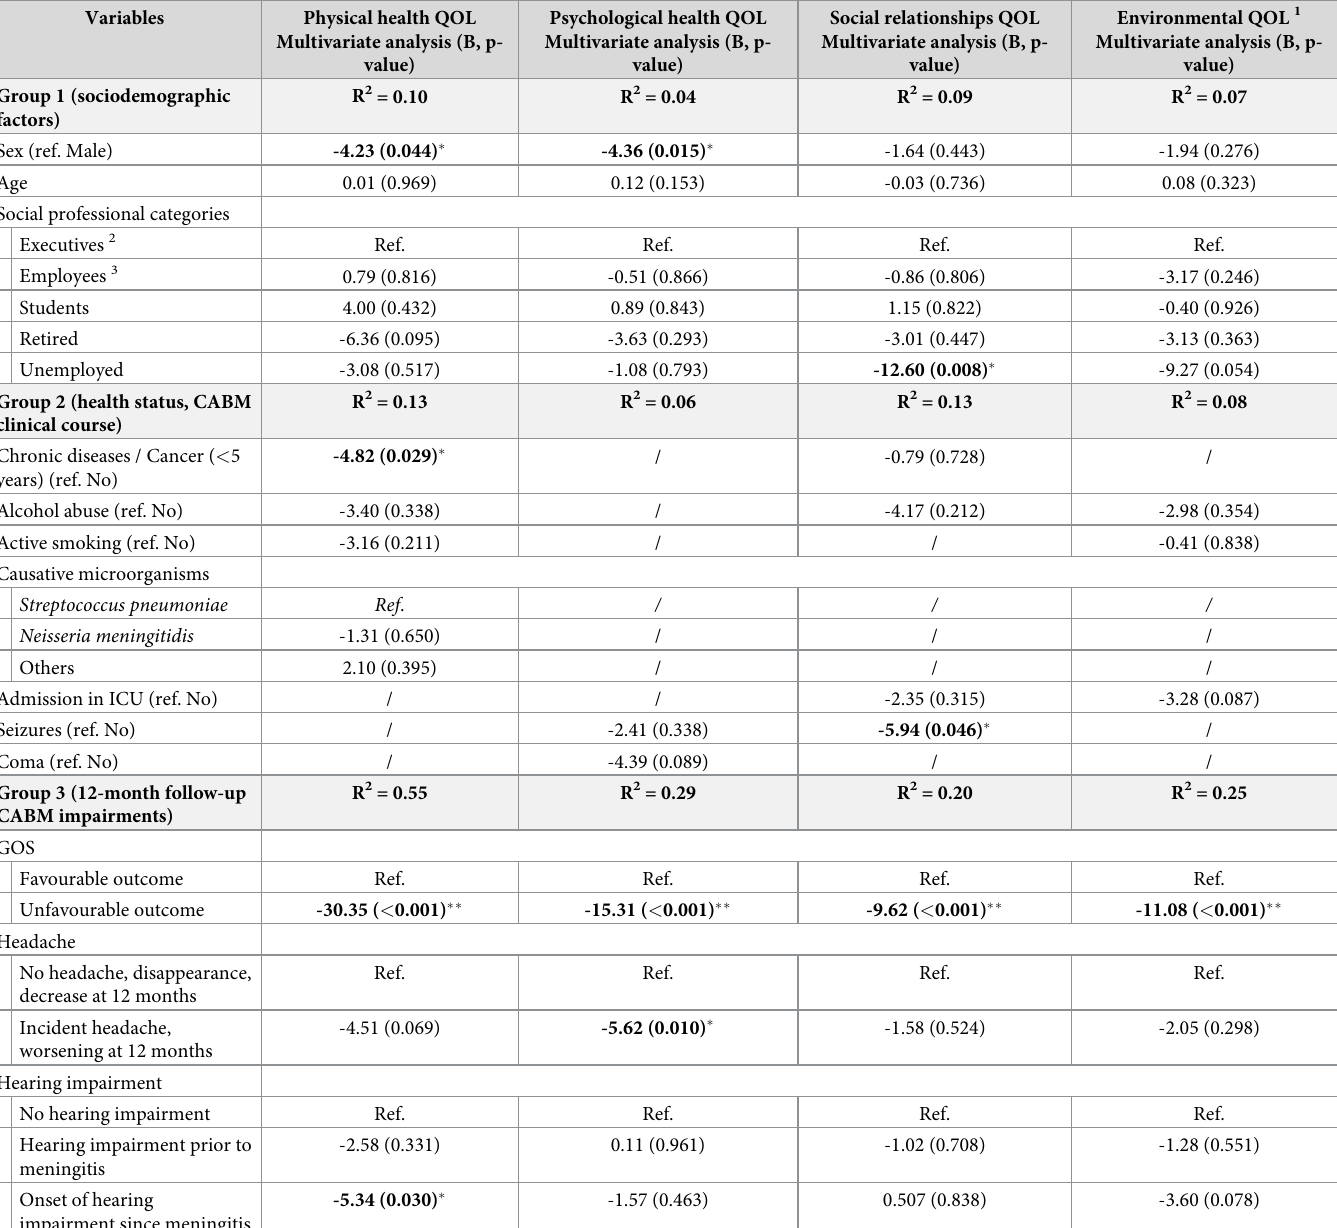
Table 3. Factors associated with QOL in adults with CABM (N = 284), COMBAT France,